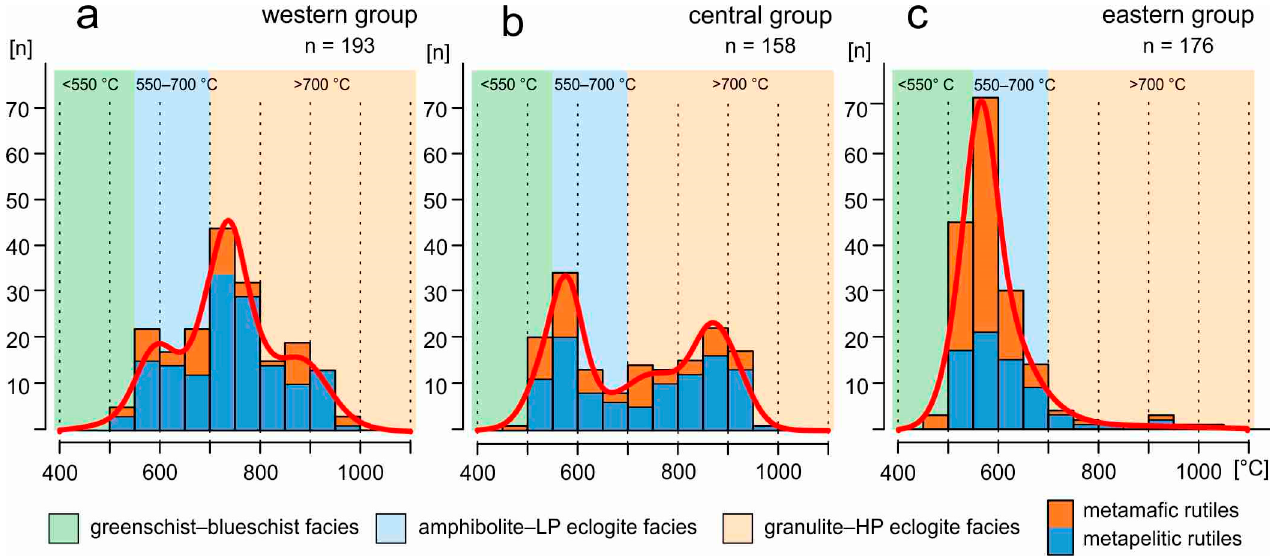
Figure 6. Summary histograms of rutile crystallization temperatures for the western ( a ), central ( b ), and eastern ( c ) groups with an indication of metamorphic facies. Temperatures were calculated using the Watson et al. [32] geothermometer.